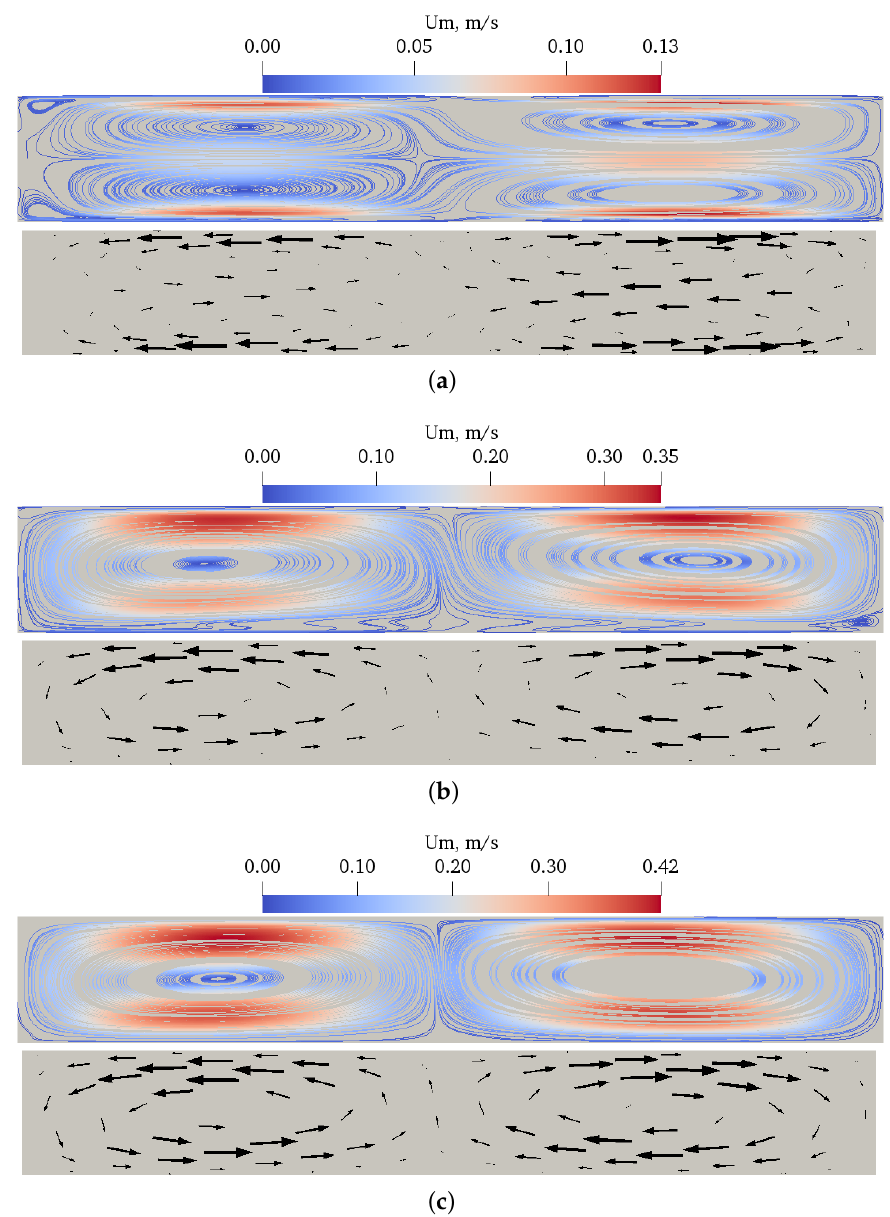
Figure 7. Streamlines depicting streaming velocity U m for Cases 3A–3C ( f = 80 kHz). ( a ) Case 3A (isothermal flow). ( b ) Case 3B, ∆ T = 20 K. ( c ) Case 3C, ∆ T = 60